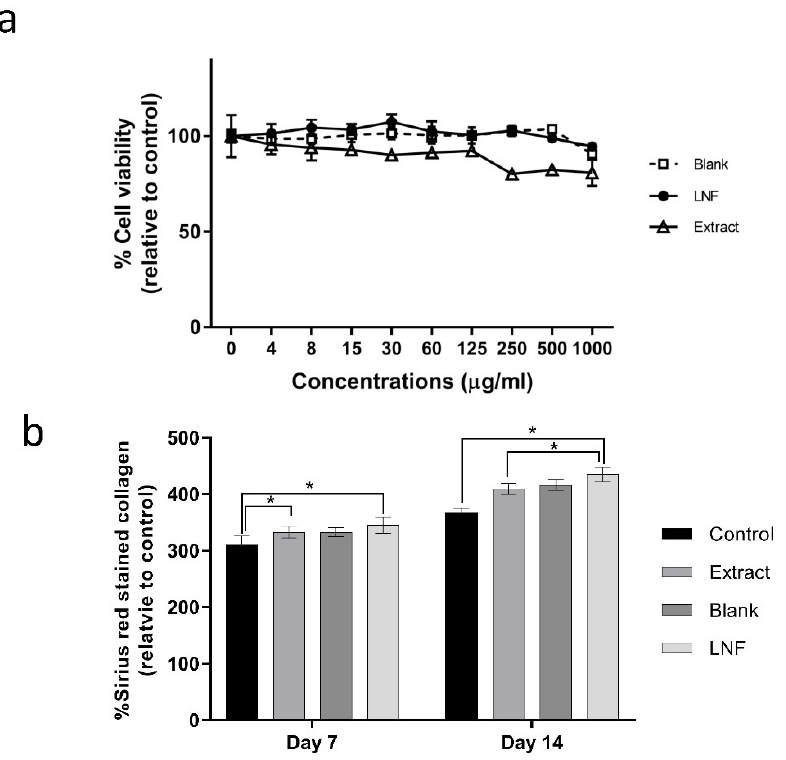
Figure 6. Evaluation of LNF activities: ( a ) Cytotoxicity induced by LNF: The effect of blank, LNF, and fenugreek extract on cell viability. Human dermal fibroblast cells were treated with different concentrations of blank (liponiosome without fenugreek extract denoted as Blank), LNF, and fenugreek extract for 24 h. Data are means ± SD ( n = 3). ( b ) Collagen production induced by LNF: The effect of LNF on collagen production. Human dermal fibroblast cells were treated with 0.005% DMSO as a control (vehicle), 7 µg/mL of extract, and 100 µg/mL of LNF (7 µg/mL of extract equivalence), together with blank particles, for 7 and 14 days. Data are represented as means ± SD ( n = 3). *, p < 0.05.